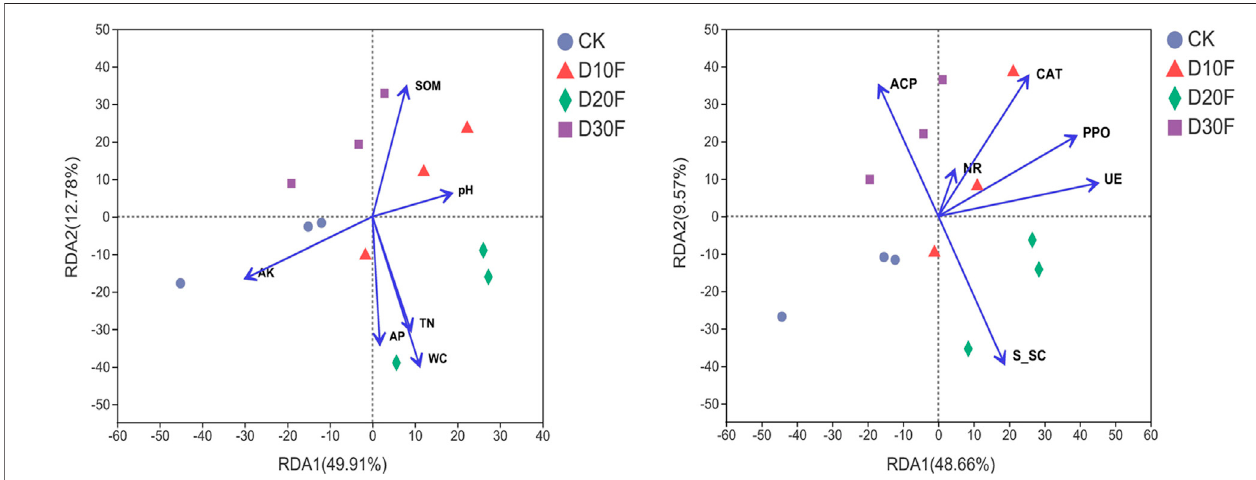
FIGURE6| Redundancyanalysis(RDA)ofdifferenttreatments fi ttingthephysicochemicalindicators (A) andenzymeindicators (B) tothebacterialcommunitydata. The direction and length of the blue arrow lines indicate the explanation of different indicators, which in fl uence the bacterial communities.